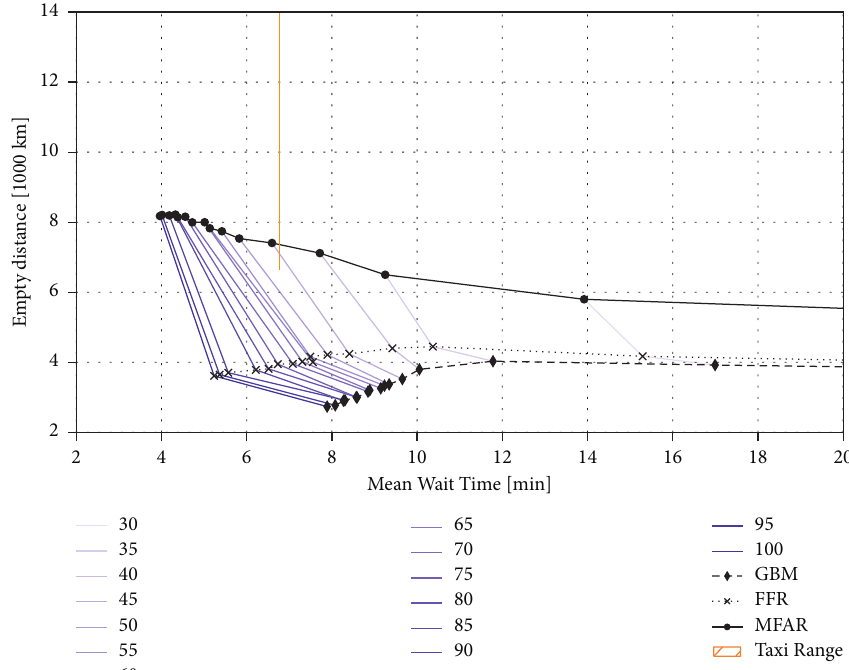
Figure 7: Mean wait time and empty vehicle distance of a coordinated mobility-on-demand system under different policies and fleet sizes for the Zurich case. The real taxi system in orange uses 95